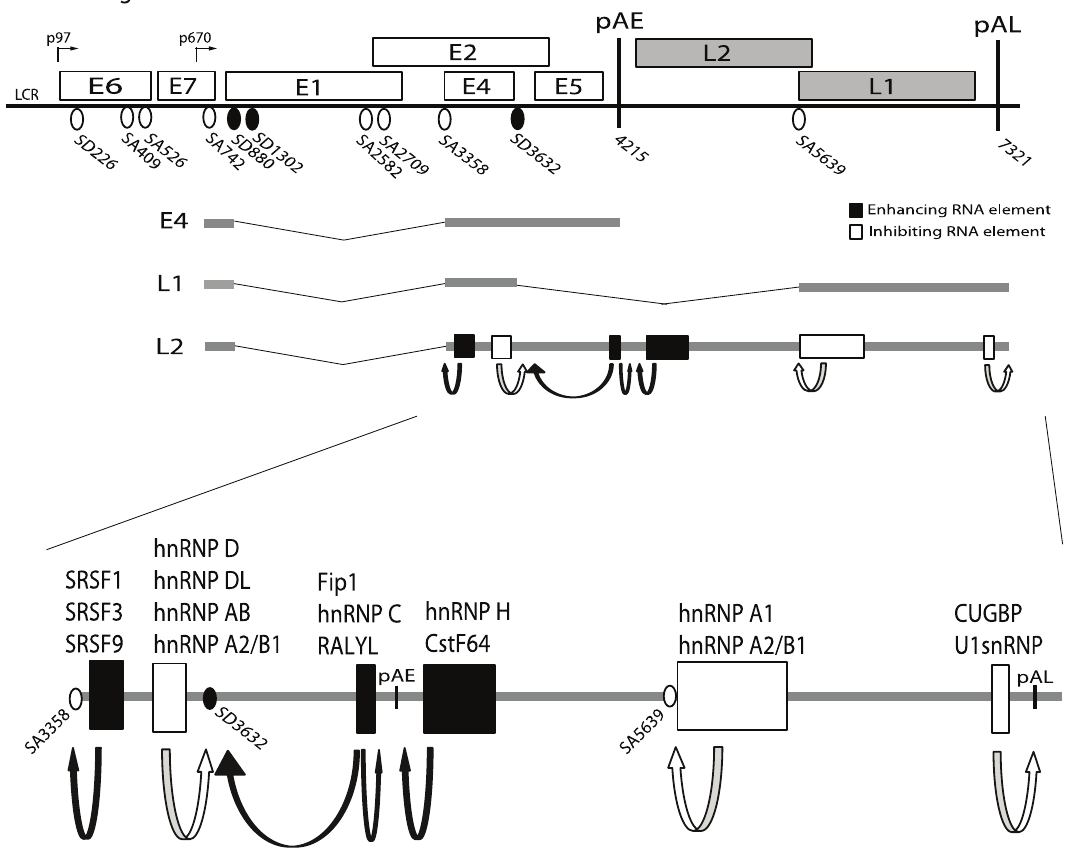
Figure 1. Schematic representation of the HPV16 genome. Boxes indicate open reading frames. HPV16 early and late promoters p97 and p670, respectively, early and late polyadenylation signals pAE and pAL, respectively, and 5'- (SD) and 3'- (SA) splice sites are indicated. A subset of HPV16 mRNAs initiating at the p670 promoter is shown and splicing regulatory elements are indicated. Filled boxes represent positive RNA elements that enhance usage of splice sites or polyA signals and white boxes represent suppressive RNA elements that inhibit splice sites or polyA sites. Examples of alternatively spliced HPV16 mRNAs initiated at early (p97) and late (p670) promoters and terminated at early (pAE) or late (pAL) polyadenylation signals are